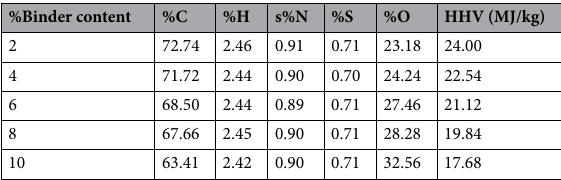
Table 2. Ultimate contents and calorific values of the briquettes.